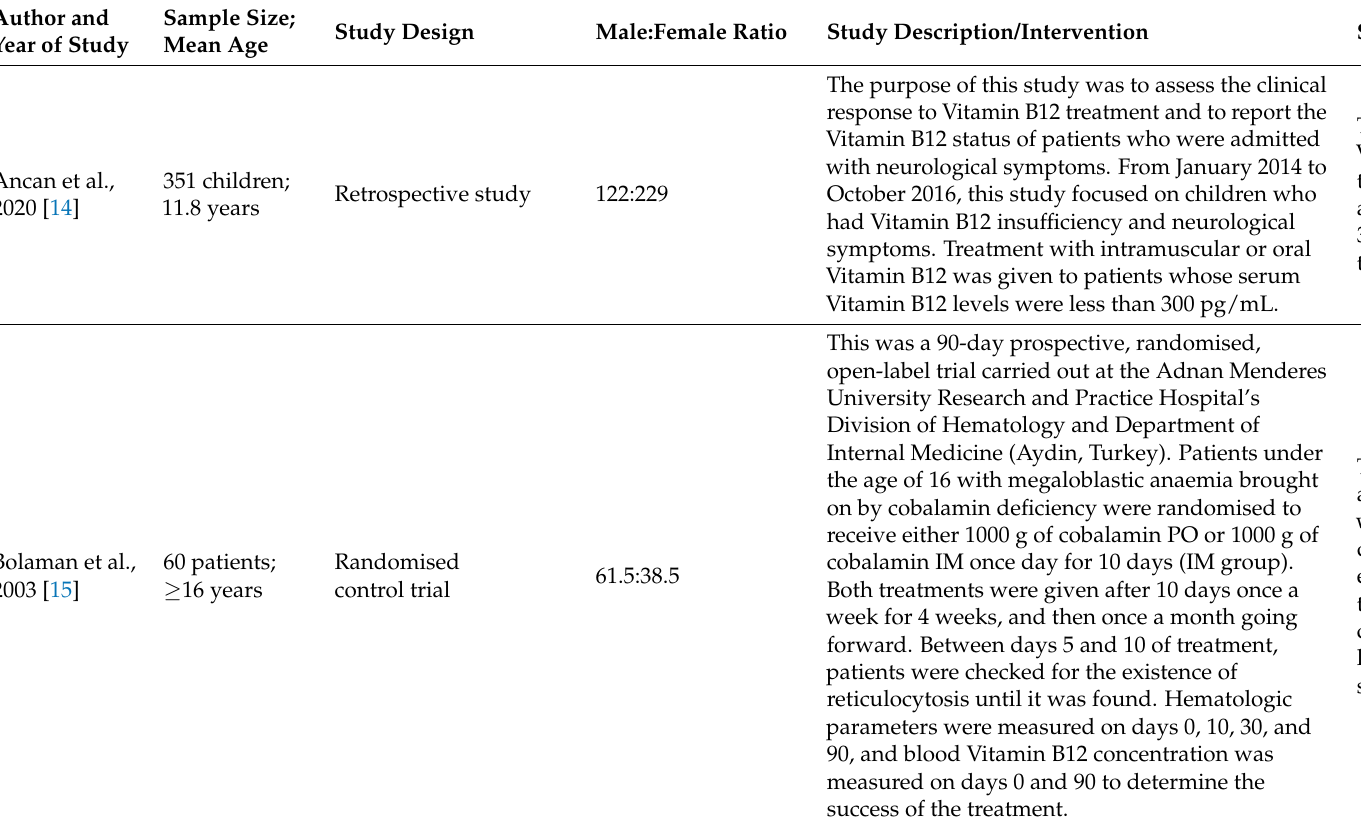
Table 2. Description and outcomes as observed in the studies selected for the systematic